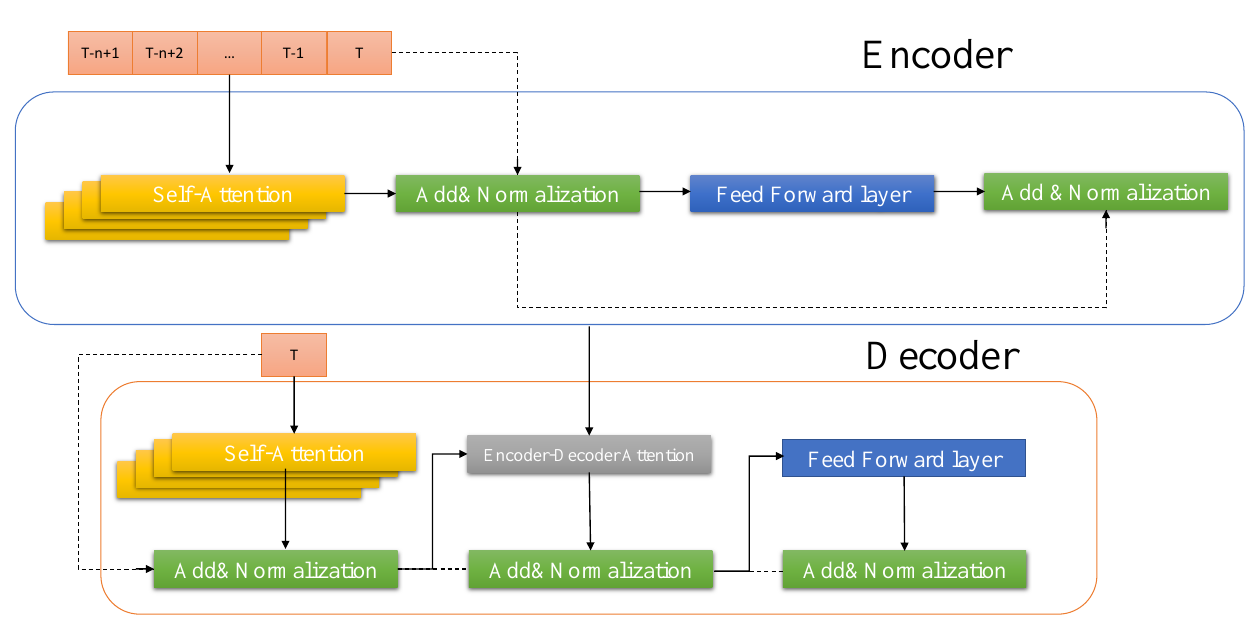
Figure 8. The specific architecture of encoder and